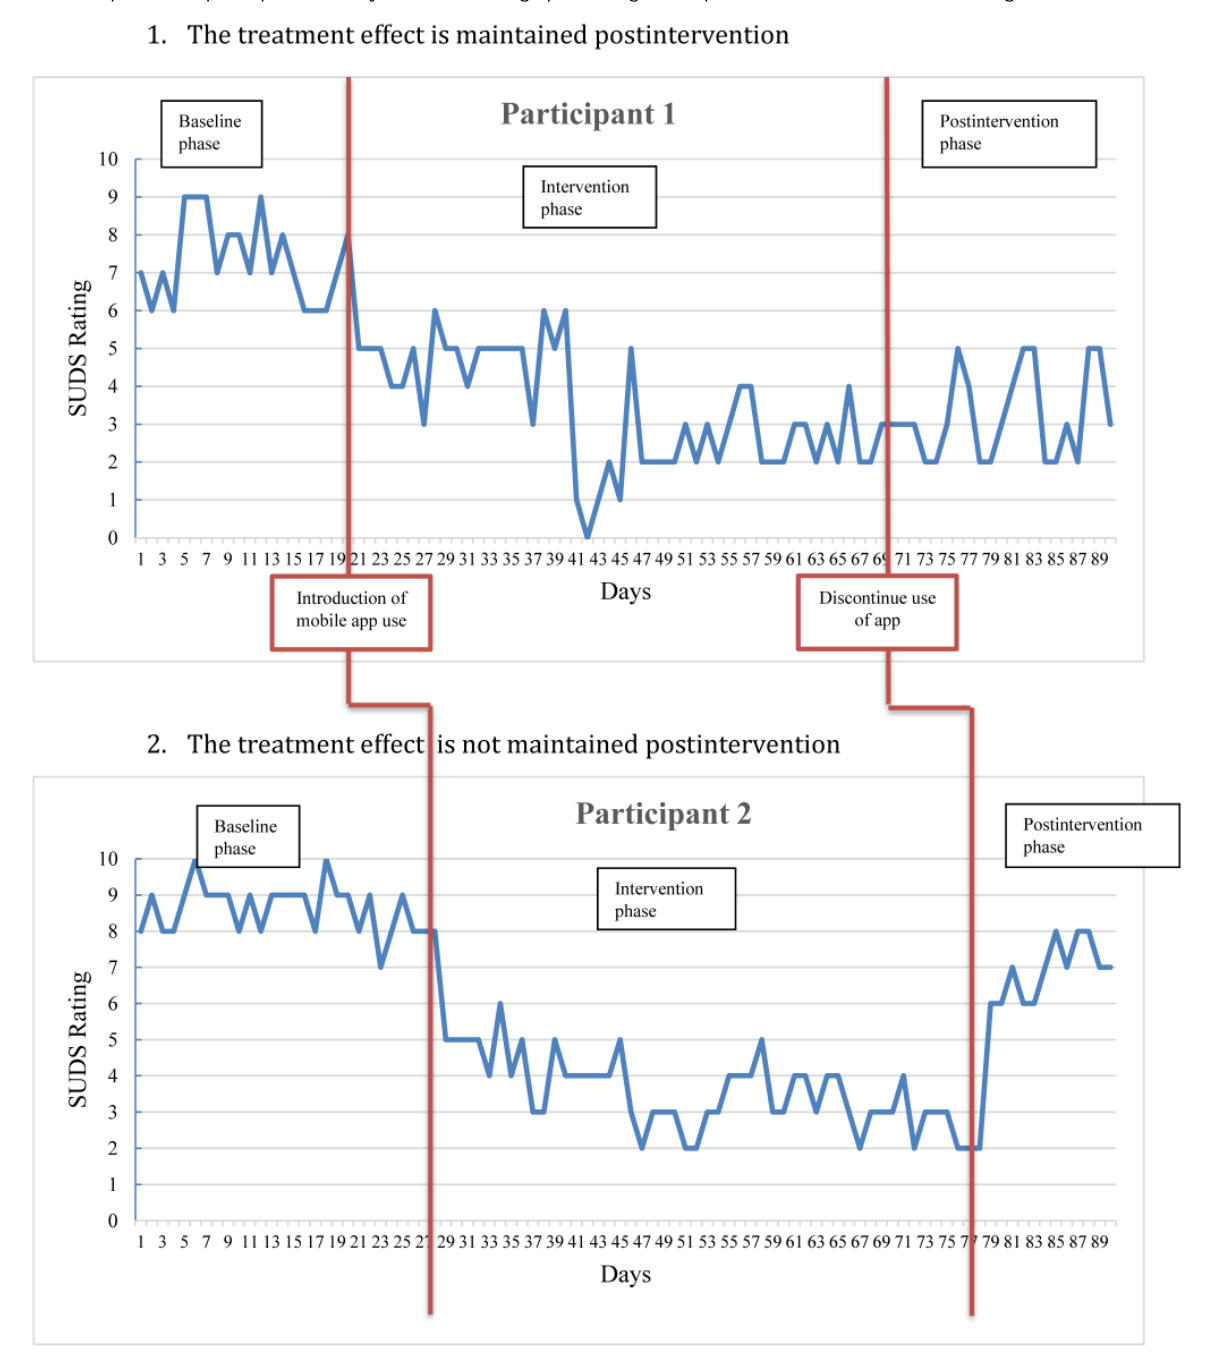
Figure 3. Example of how participant data may be affected and graphed using a multiple baseline across-individuals